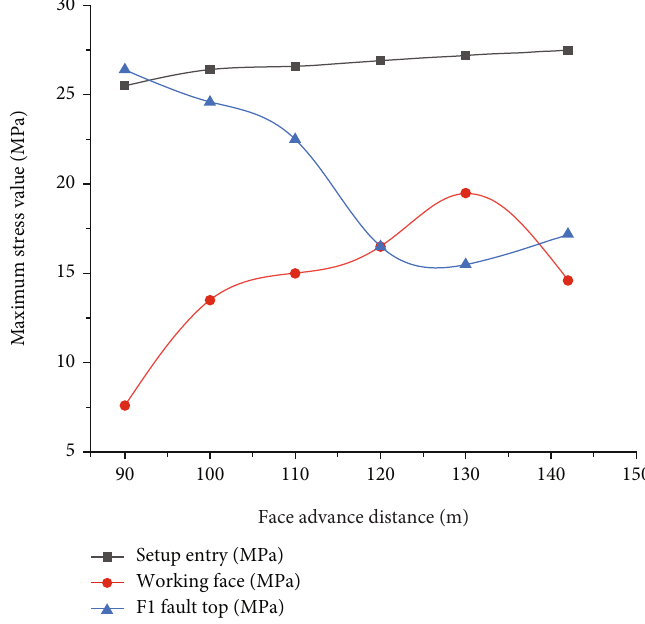
Figure 8: Vertical stress